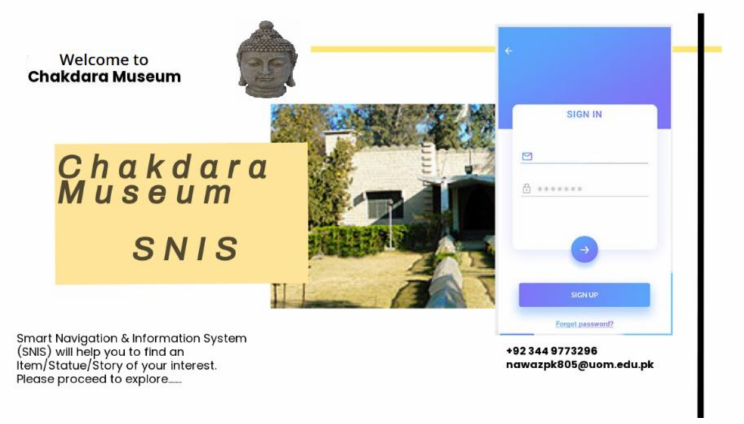
Figure 9. Authentication after receiving a ticket at the help desk.